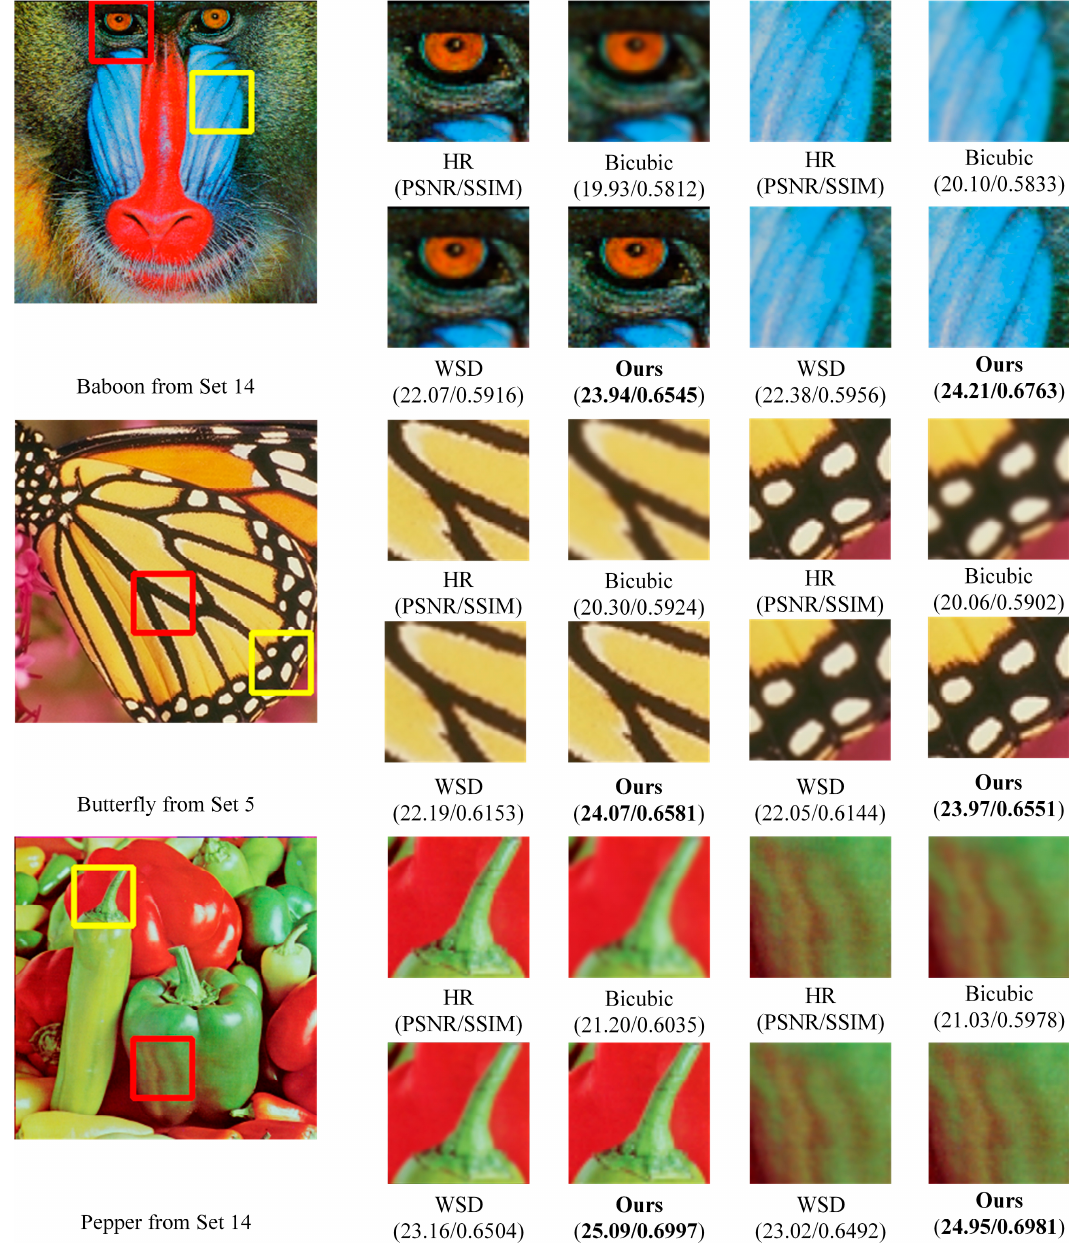
Figure 7. The qualitative super-resolution comparison between our work and WSD with an upscaling factor of 4. Whether PSNR or SSIM, the SR results have been improved